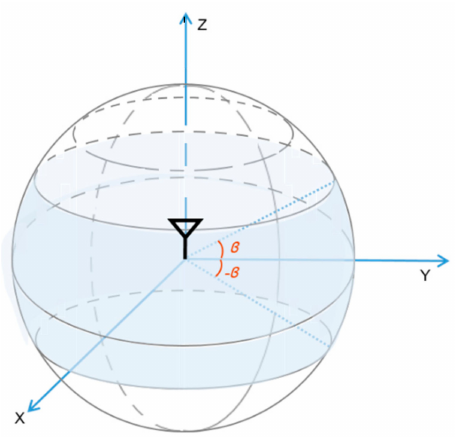
Figure 9. The test schematic of near-horizontal part radiated power ( NHPRP